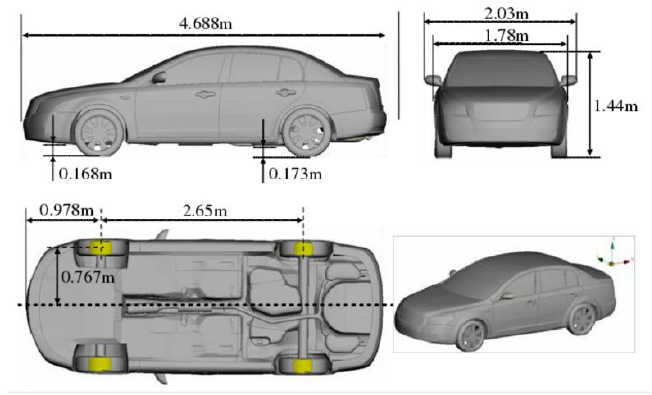
Figure 8. Geometrical size of the vehicle model.